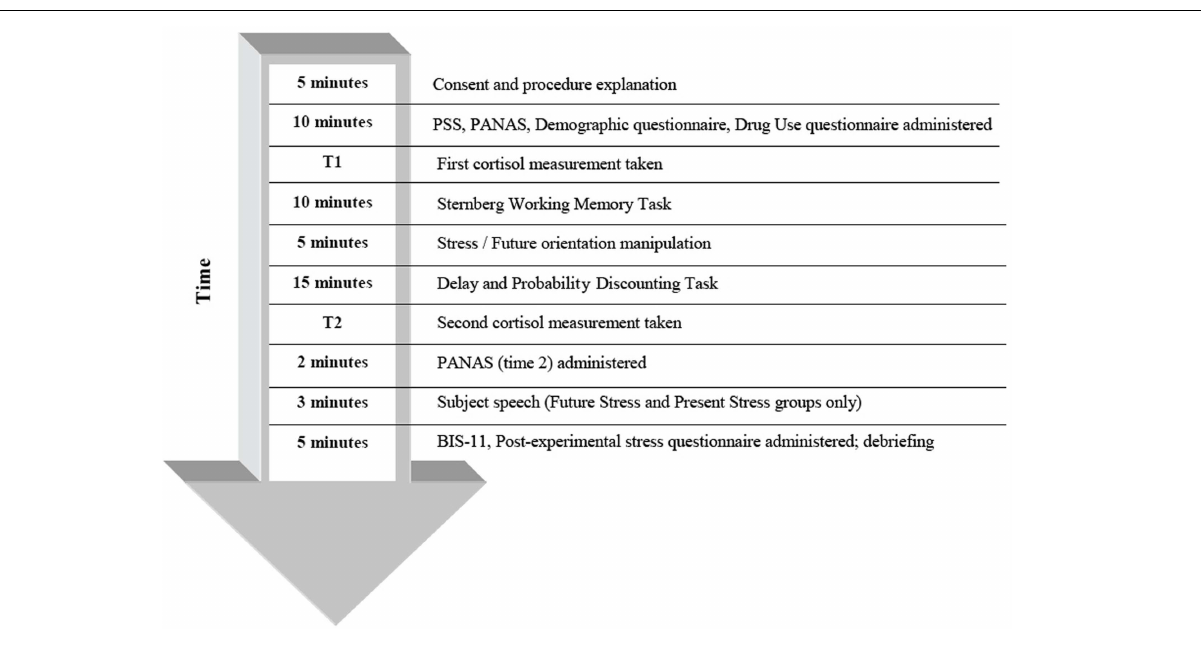
FIGURE 1 |Timeline for